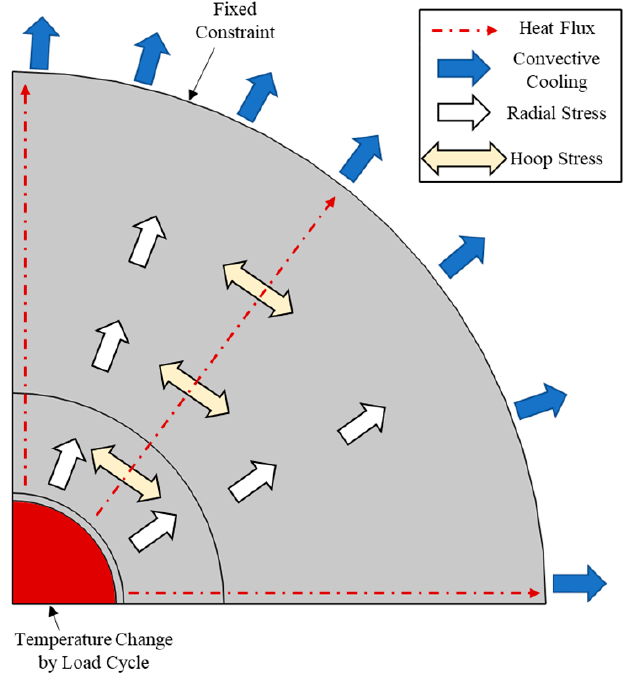
The boundary conditions applied for the thermal mechanical analysis are shown in Figure 4. Assuming that there is no change in the outer diameter of the joint, the fixed constraint condition was applied. In addition, to analyze the interfacial pressure according to the load condition change, the elastic modulus and the thermal expansion coefficient including the temperature term were applied. Since it is difficult to set the initial internal stress of the installed joint, only the change in interfacial pressure due to thermal variability after installation was analyzed. The conductor temperature was the same as the load cycle temperature profile. The main parameters used in the thermal mechanical model are shown in Table 2 [34].